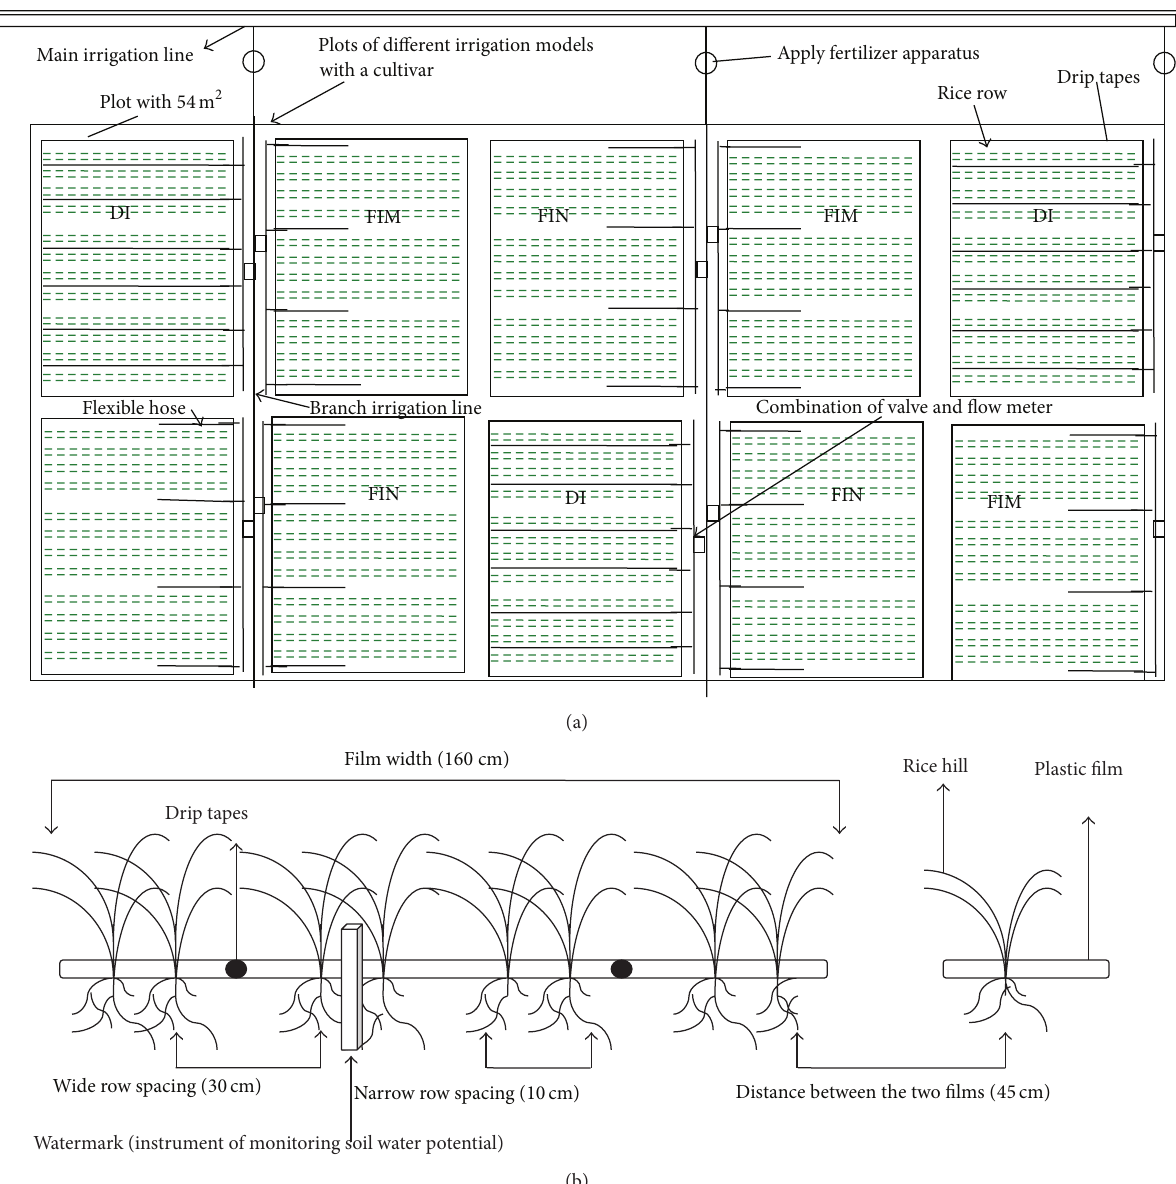
Figure 2: Experiment layout (a) and sketch map of planting mode (b) under nonflooded irrigation treatments in Shihezi in both years.